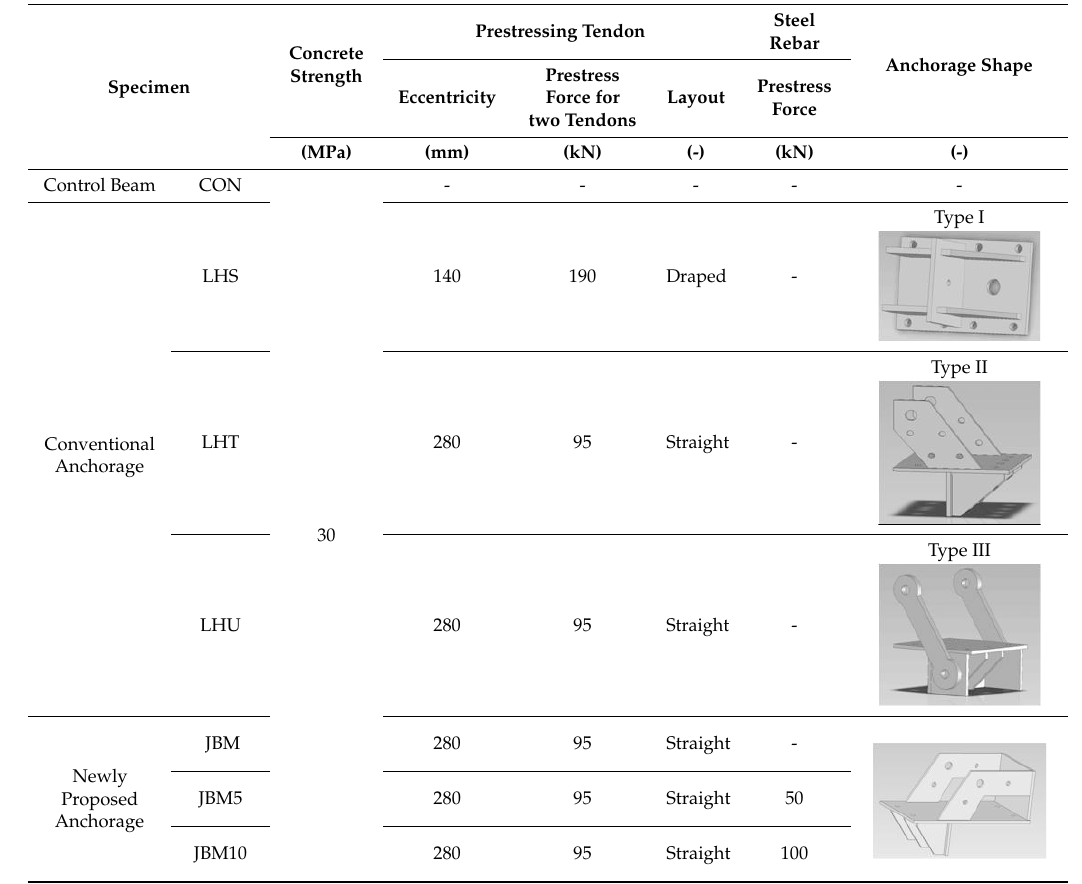
Conventional Anchorage